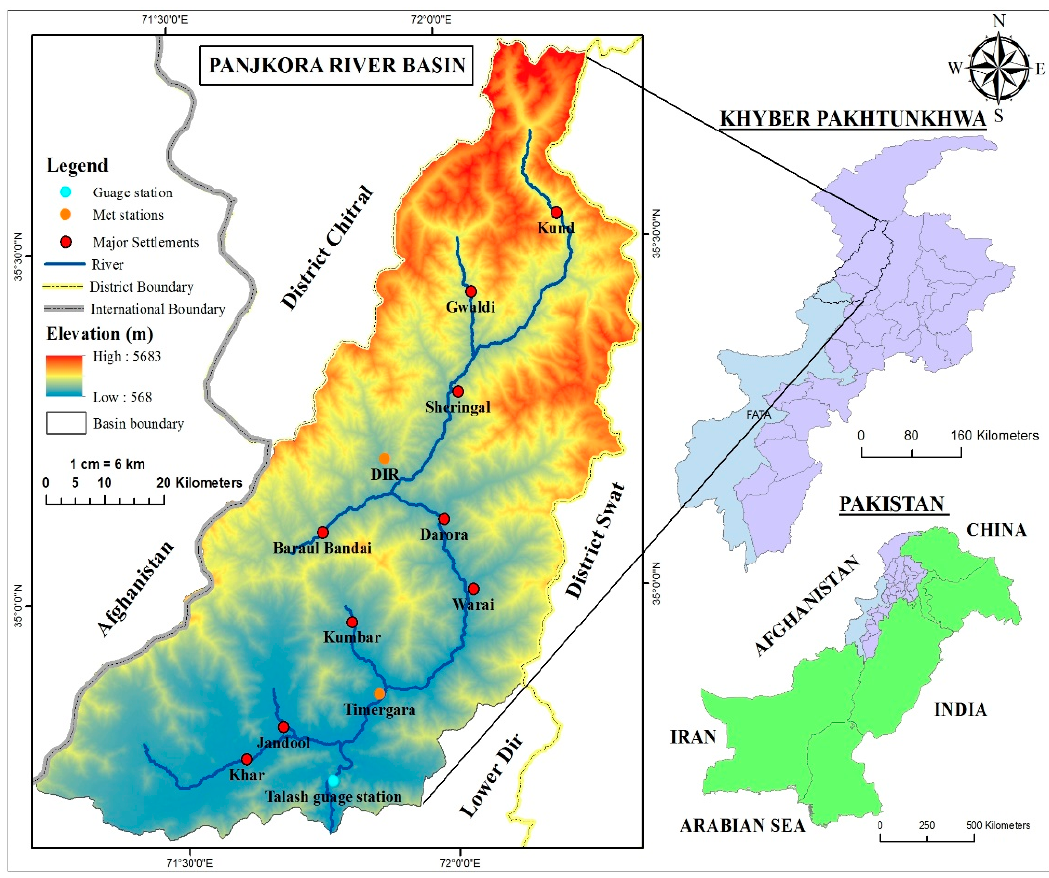
Figure 1. Location map of the study area.